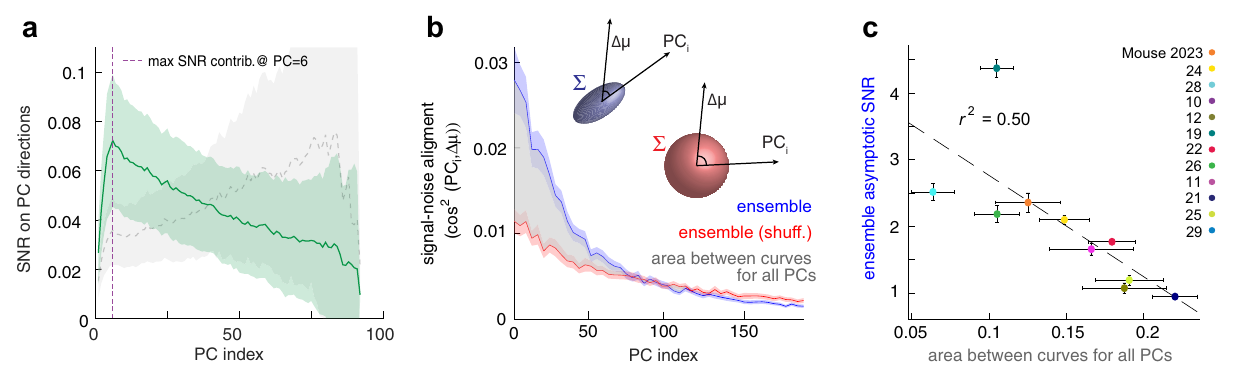
Fig. 4 Spatial information is distributed across many dimensions. a The SNR along each noise covariance matrix eigenvector. SNR computation using the training set (dotted gray) or the testing set (solid green). Median and the 95% con fi dence interval (shaded area) over spatial bins, averaged over 100 different train (gray) and test (green) sets and aggregated over 73 sessions with 10 mice. The fi rst dimensions increasingly accumulate contribution to SNR, peaking at PC 6 (purple dashed line). The accumulated contribution up to this point is a small percentage of the area under the curve as the PC indices grow to large numbers. b cos 2 between the signal direction Δμ and the noise mode direction PC i for ensemble data (blue) and ensemble shuf fl ed data (red). Shaded area is the 95% con fi dence interval based on the same testing set as in a . The gray area between red and bluecurves is an empirical estimate of the overlap between signal and noise due to noise correlations. Gray area is computed using all available PC directions per session, which were limited by data size. c The total cos 2 overlap between signal direction Δμ and each noise PC direction in the shuf fl ed data, subtracted from the corresponding quantity in the unmodi fi ed data, correlates with the asymptotic SNR from Supp.Fig. 11c. Increase in signal-noise overlap due to noise correlations predicts the limit of spatial information (Pearson ’ s corr. = 0.81, r 2 = 0.50, p < 0.05, n = 73 sessions with 10 mice. Each dot represents the average over sessions for each animal, error bars are the 95% con fi dence intervals over each animal ’ s sessions). Noise structure explains how noise correlation limits hippocampal spatial information. Source data is provided as a Source Data fi